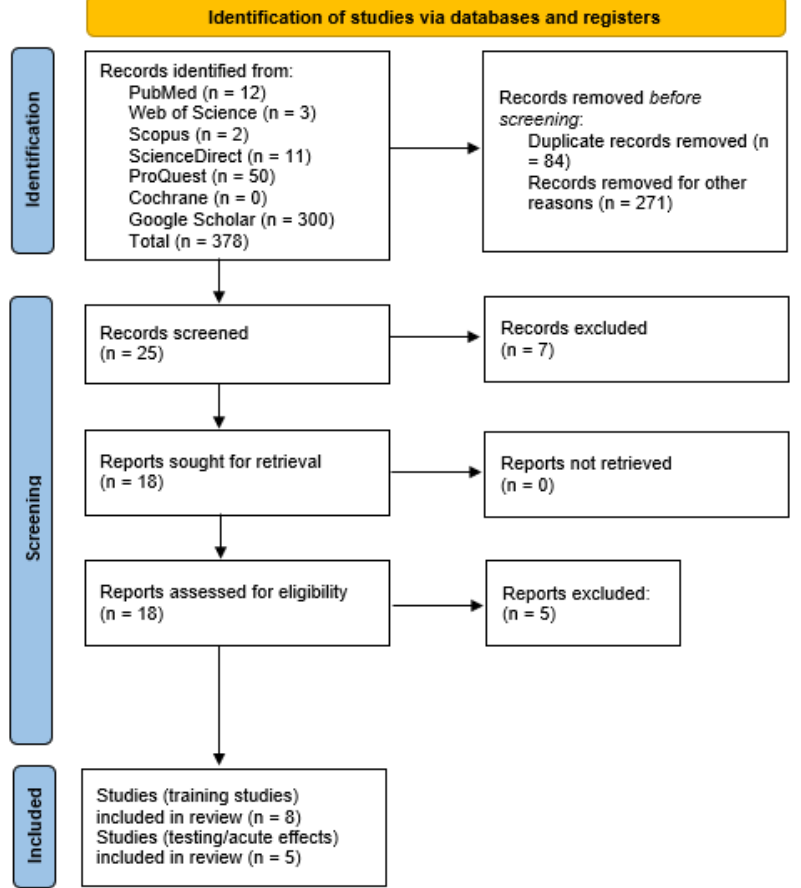
Figure 2. Flow diagram representing the selection process.